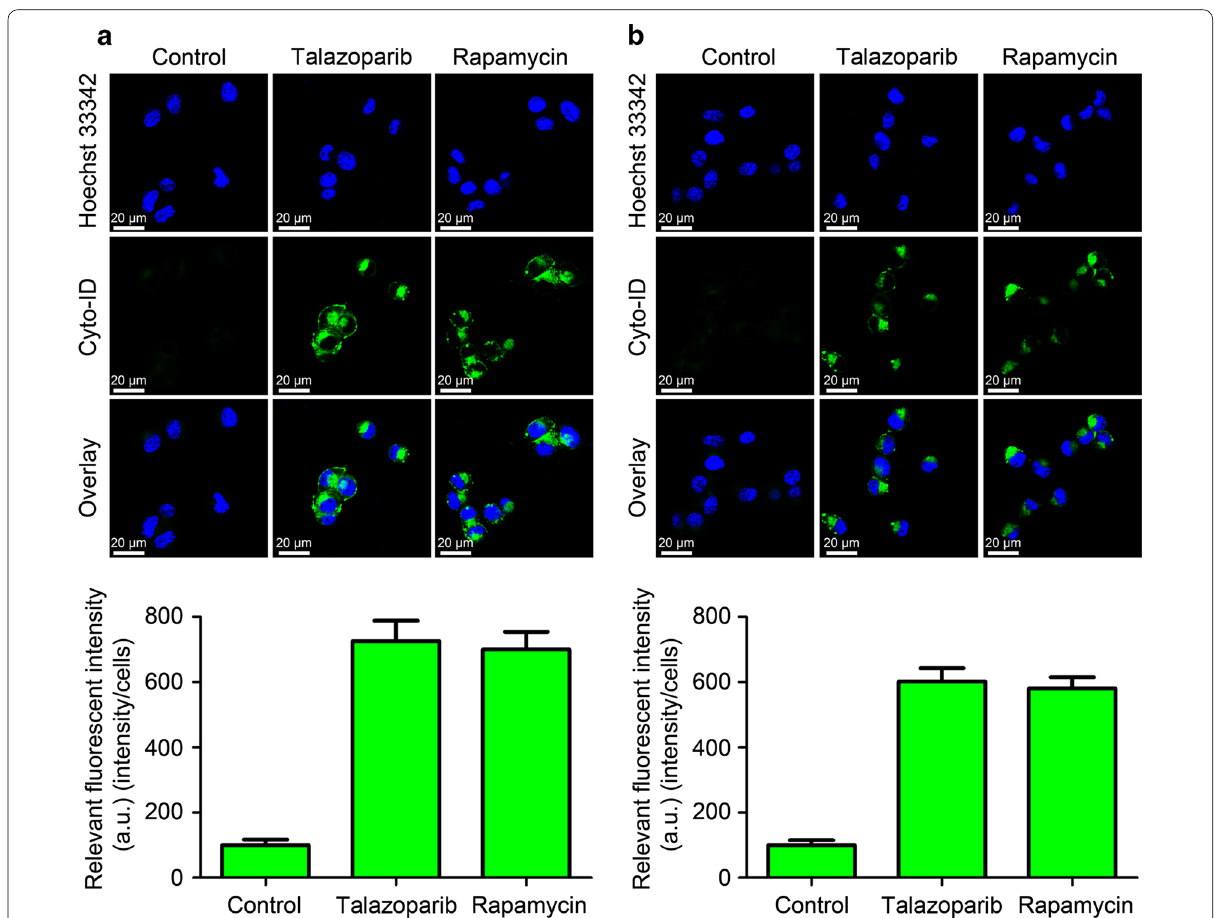
Fig. 4 PARP inhibitor talazoparib induced autophagosomes accumulation in CML cells. Cyto-ID green dye was employed to detect the accumulation of autophagosomes in CML P#1 ( a ) and P#2 cells ( b ) after exposure to talazoparib (20 μM) for 48 h. Rapamycin was used as the positive control ( N 3, mean = ±